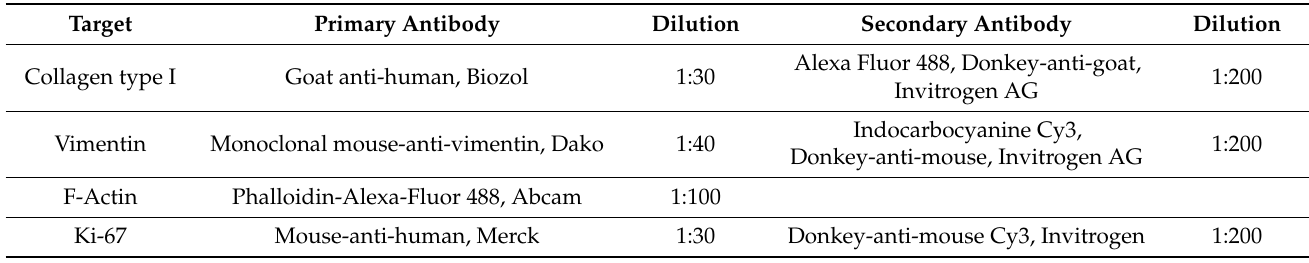
Table 1. Antibodies used for